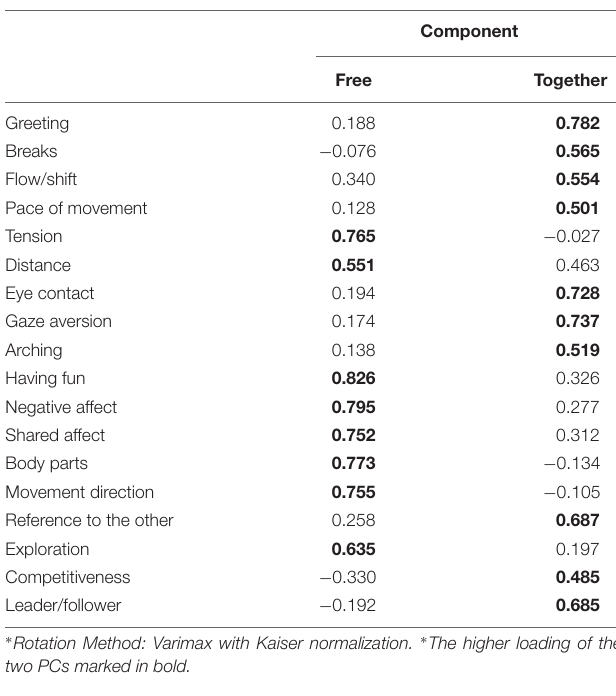
TABLE 3 | Loading of the MG scales on the two (PCs): free and together.